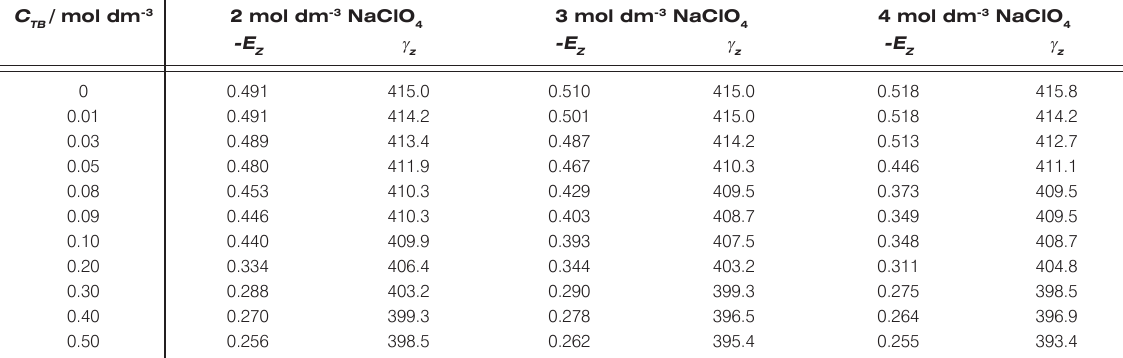
/mN m -1 at E for the studied systems. z z